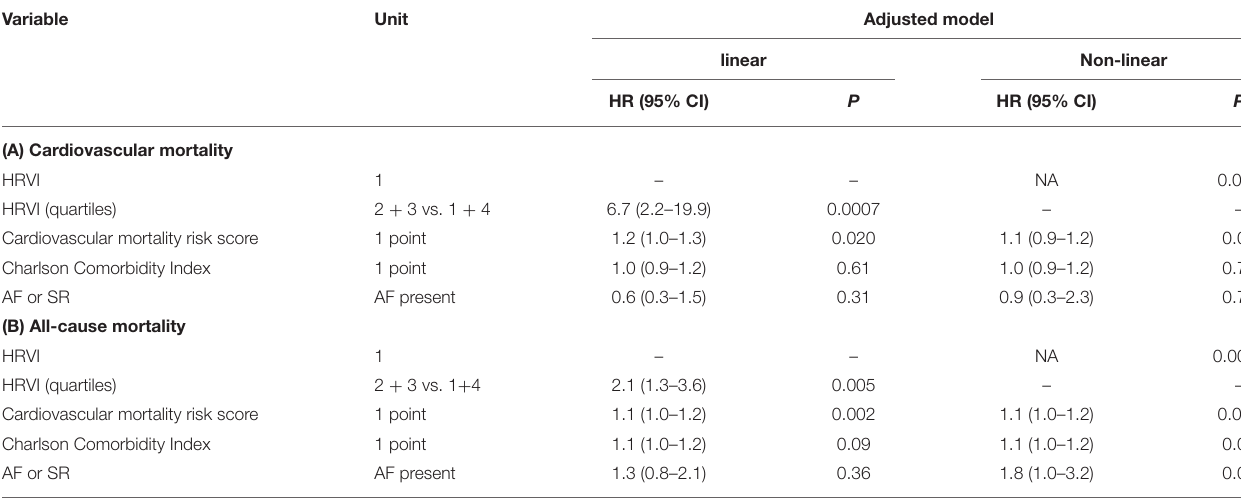
TABLE 5 | Sensitivity analysis of adjusted linear and non-linear Cox regression models additionally including the presence of atrial fibrillation (AF) or sinus rhythm (SR) for (A) cardiovascular and (B) all-cause mortality. Variable